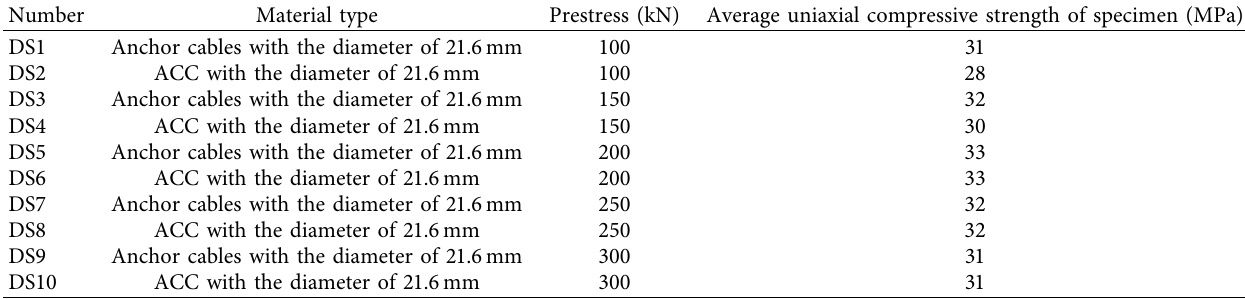
Table 1: Double-shear test schedule.